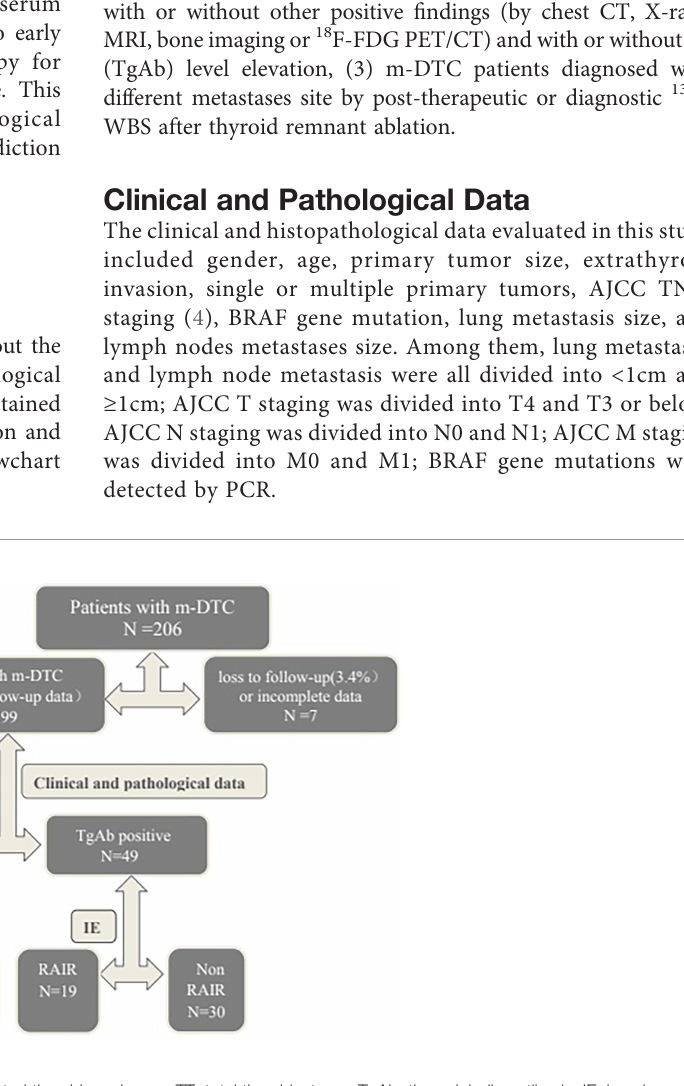
FIGURE 1 | Flowchart of the participants. m-DTC, metastatic differentiated thyroid carcinoma; TT, total thyroidectomy; TgAb, thyroglobulin antibody; IE, imaging examination(WBS, CT, MRI, bone imaging or 18 F-FDG PET-CT); RAIR, Radioactive